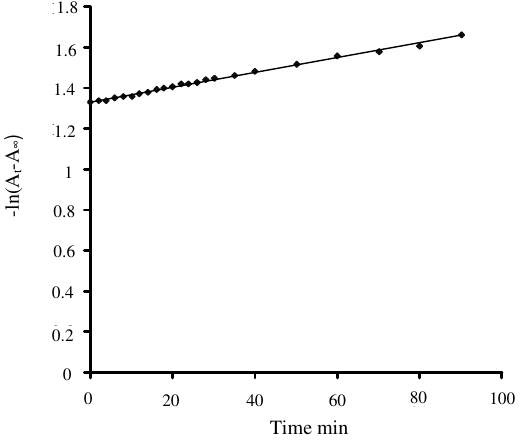
Figure 1. Determination of k